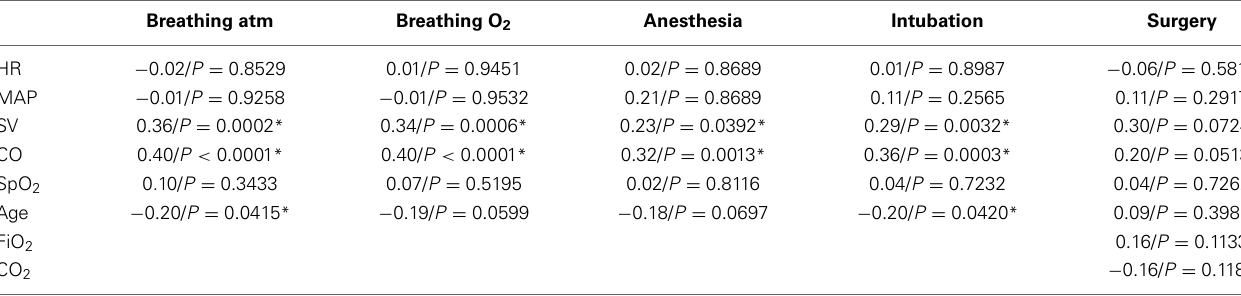
Table 2 | Relationship between frontal lobe oxygenation and cardiovascular variables. Breathing atm Breathing O 2 Anesthesia Intubation